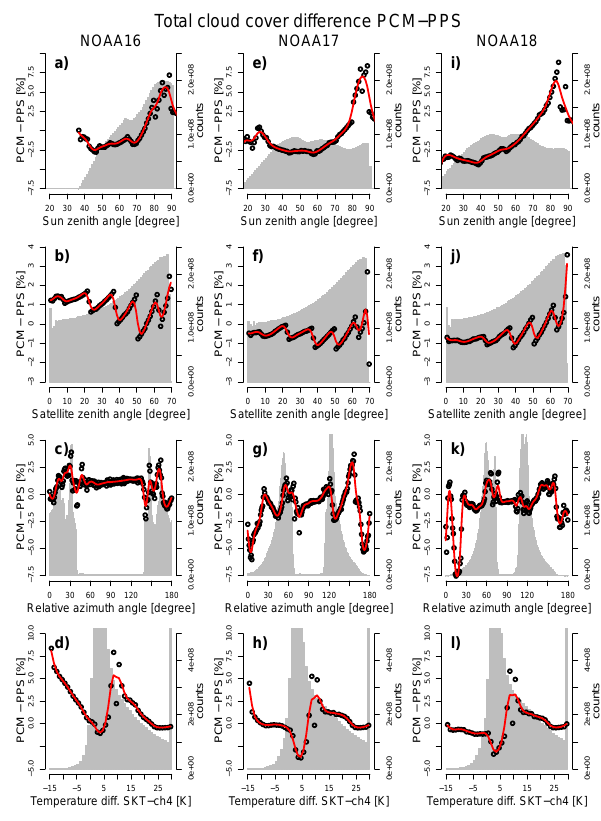
Fig. 7. Total cloud cover differences PCM–PPS as a function of se- lected variables derived from the annual pixel counts for the years 2011 (NOAA16) and 2008 (NOAA17 and 18). Data frequency is presented as grey-shaded histograms. Red lines denote trends com- puted by the smoothing spline method. For details see Sect. 4.1.